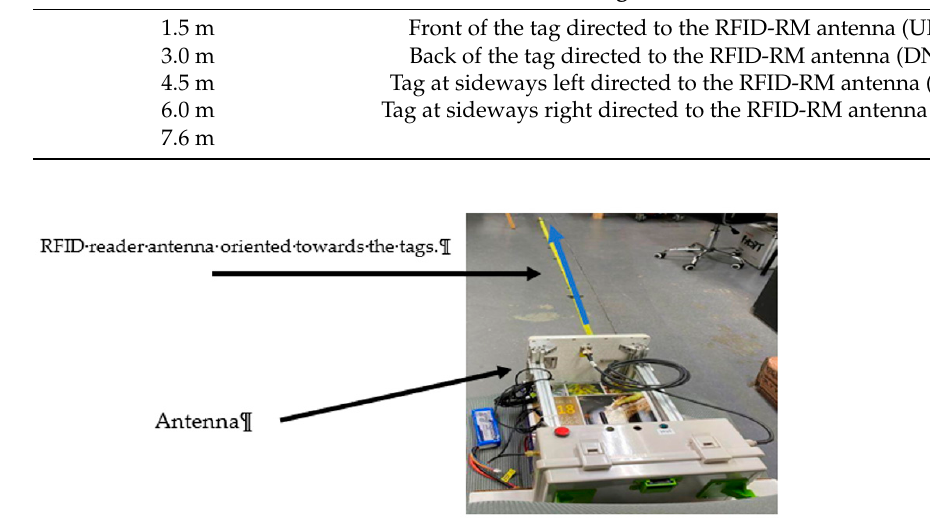
Figure 6. RFID-RM scanning tags during the first laboratory experiment. Table 3. The treatment combinations for laboratory experiment 2.6.2. Table 2. Factors (2) evaluated in the first laboratory experiment for a total of nine treatments.